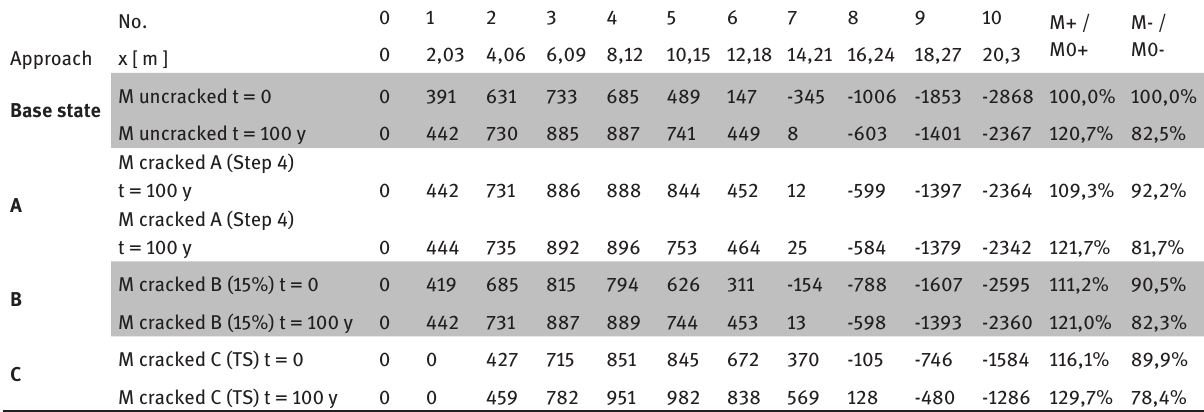
Table 2: Bending moment values (kN m) along the girder’s length (m0 due to creep in dependence of the assumed approach (A, B, C). Numerical interpretation of Fig.